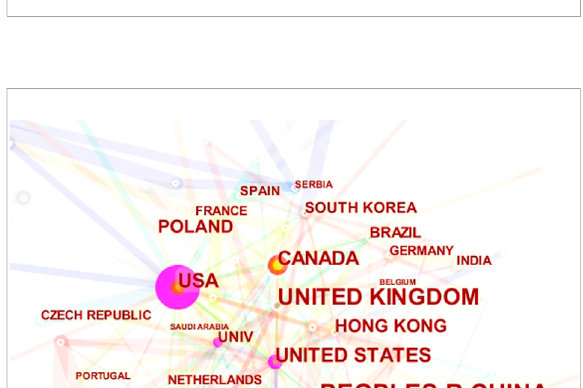
FIGURE 3 Journal analysis.